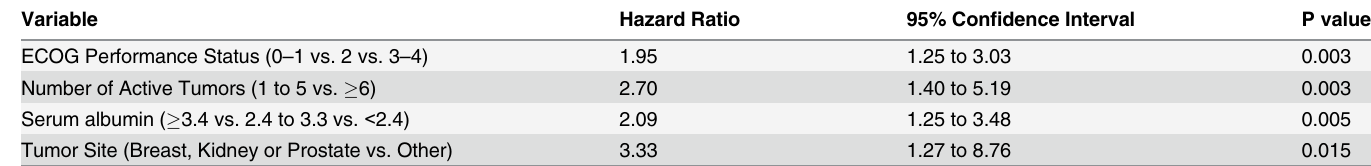
Table 3. Cox multivariable analysis of predictors of overall